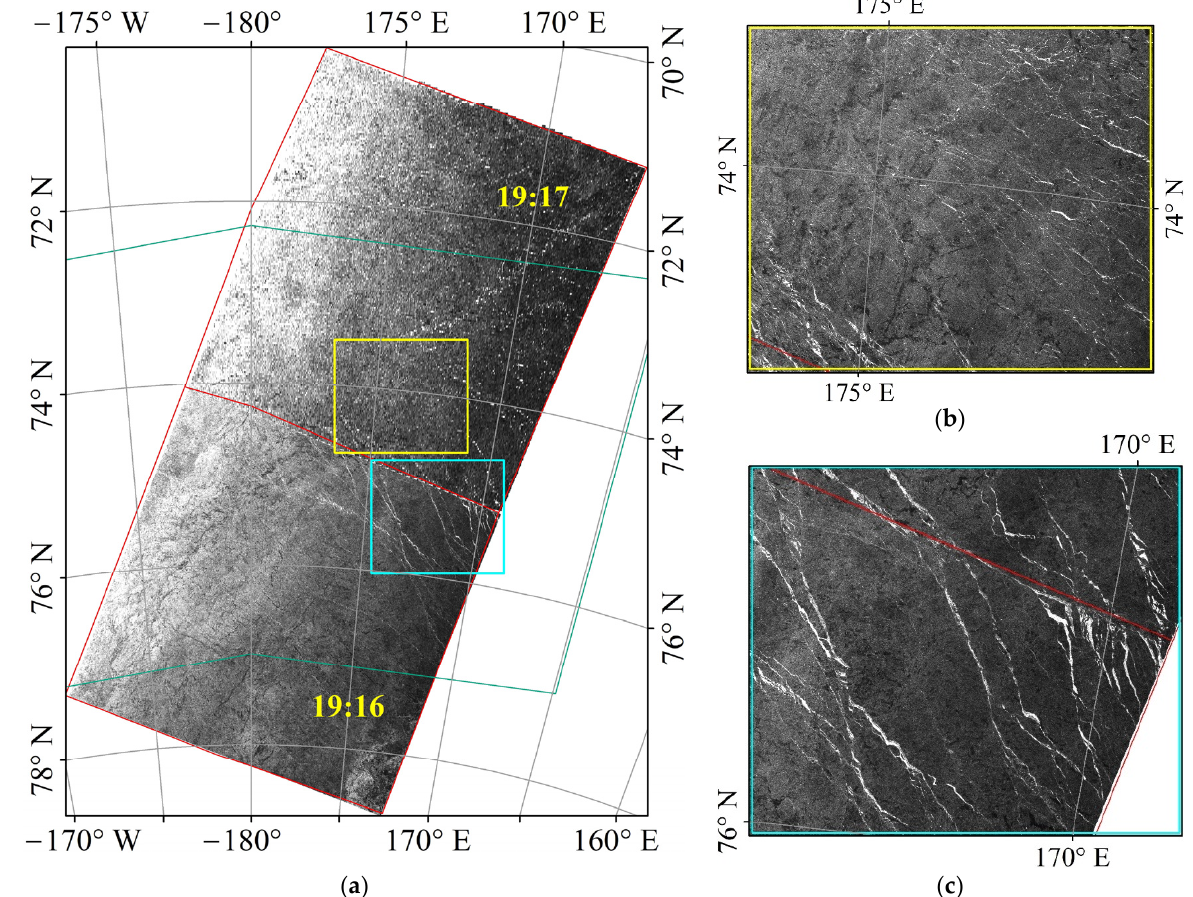
Figure 14. Two Sentinel-1 SAR images of FYI on 19 January 2020. ( a ) Two images obtained at 19:16 and 19:17. Red polygon, regions covered by two images; green polygon, FYI region; yellow rectan- gular box, uniform region; cyan rectangular box, complex region; ( b ) Uniform area (yellow rectan- gular box); ( c ) complex area (cyan rectangular box).